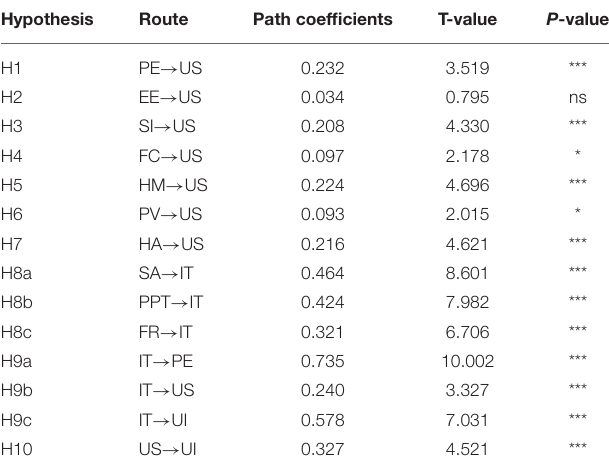
TABLE 4 | Results of hypotheses tests (entire samples). Hypothesis